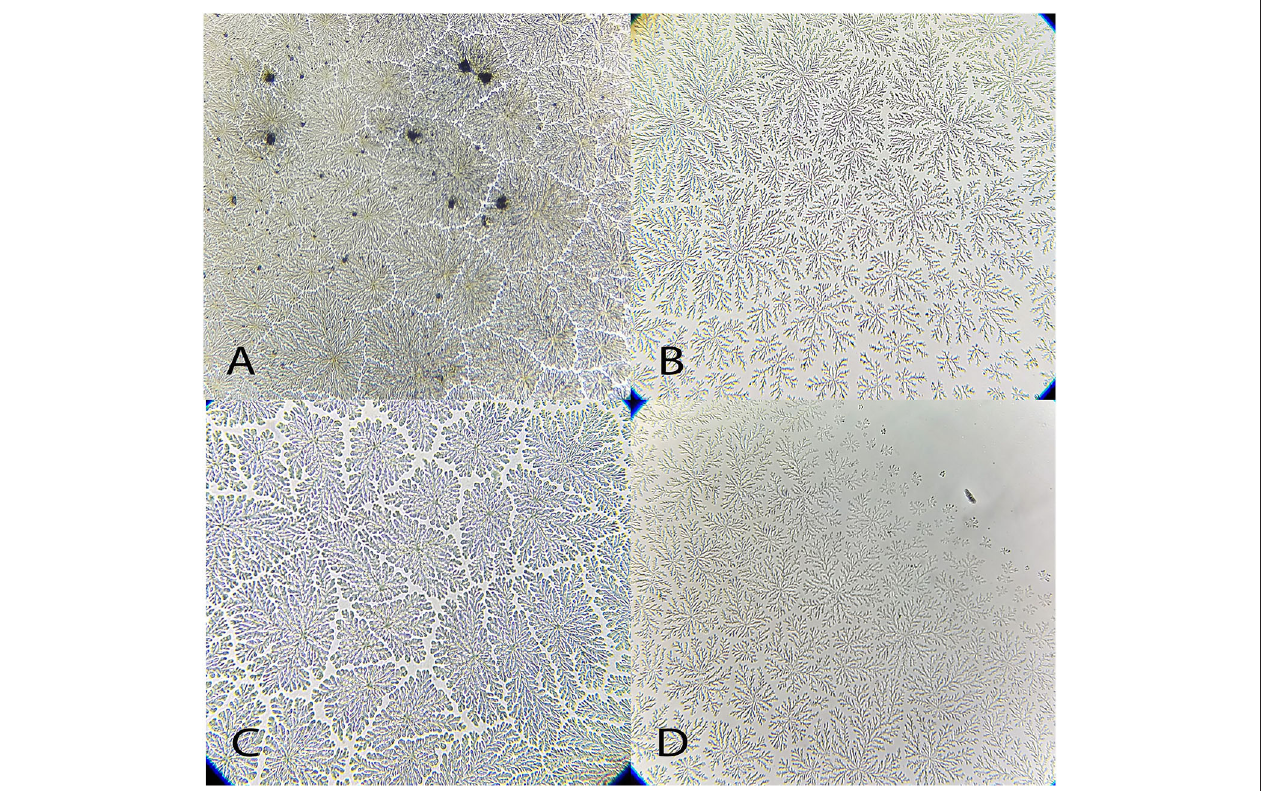
FIGURE 7 | Examples of Tyto alba tear ferning patterns, according to the Rolando and Masmali grading scales. (A) Type I (Rolando scale); (B) Type II (Rolando scale), grading 1 (Masmali scale); (C) grading 1 (Masmali scale); (D) Type III (Rolando scale), grading 3 (Masmali scale).